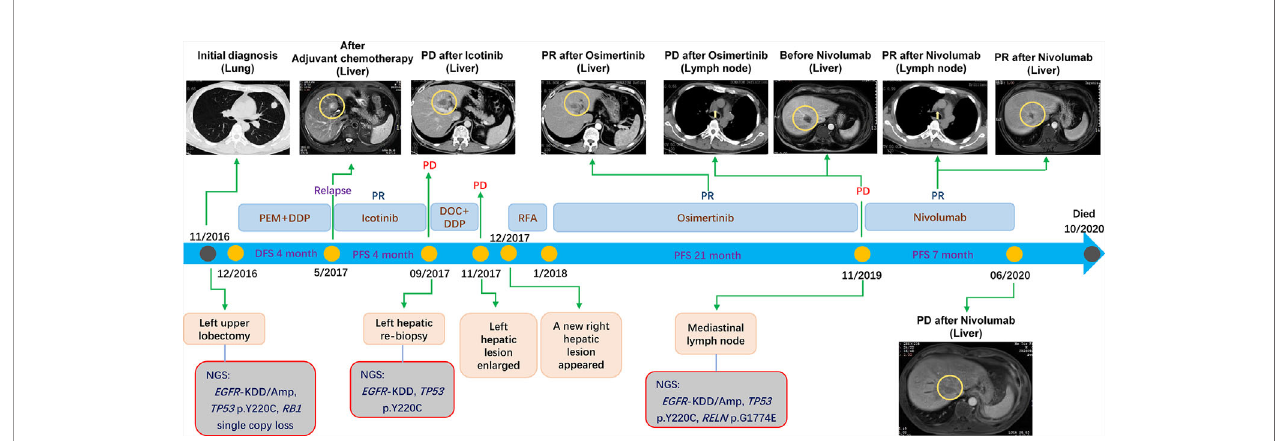
FIGURE 1 | The timeline showing the history of treatment and examinations for the patient under current